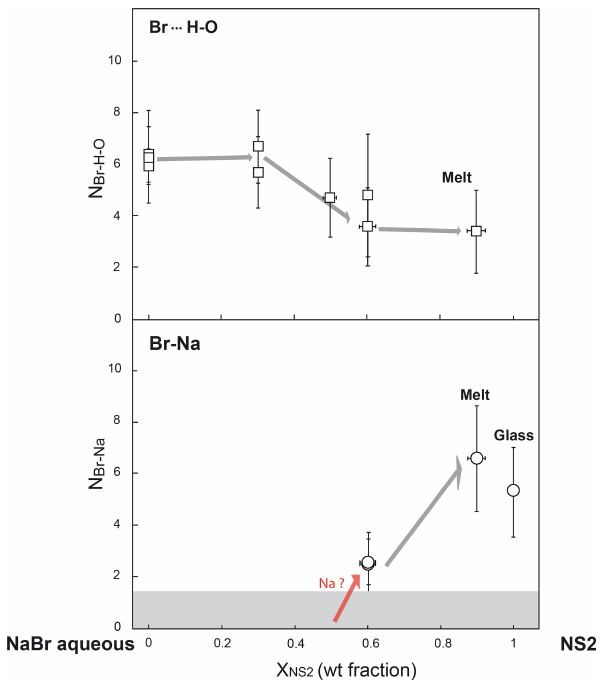
Figure 6. Evolution of bromine coordination numbers with oxy- gen (from H 2 O molecules) and sodium ( N Br ... H − O and N Br − Na ) as a function of fluid composition (i.e., the weight fraction of NS2 dissolved in the fluid) along the NaBr aqueous solution–NS2 join. The gray field shows the detection limit (DL) for Br–Na complexes, which corresponds to the maximum Br–Na coordination number ( N Br − Na ) determined for 3wt% NaBr aqueous solution at ambient conditions and 450 ◦ C (DL<1.5